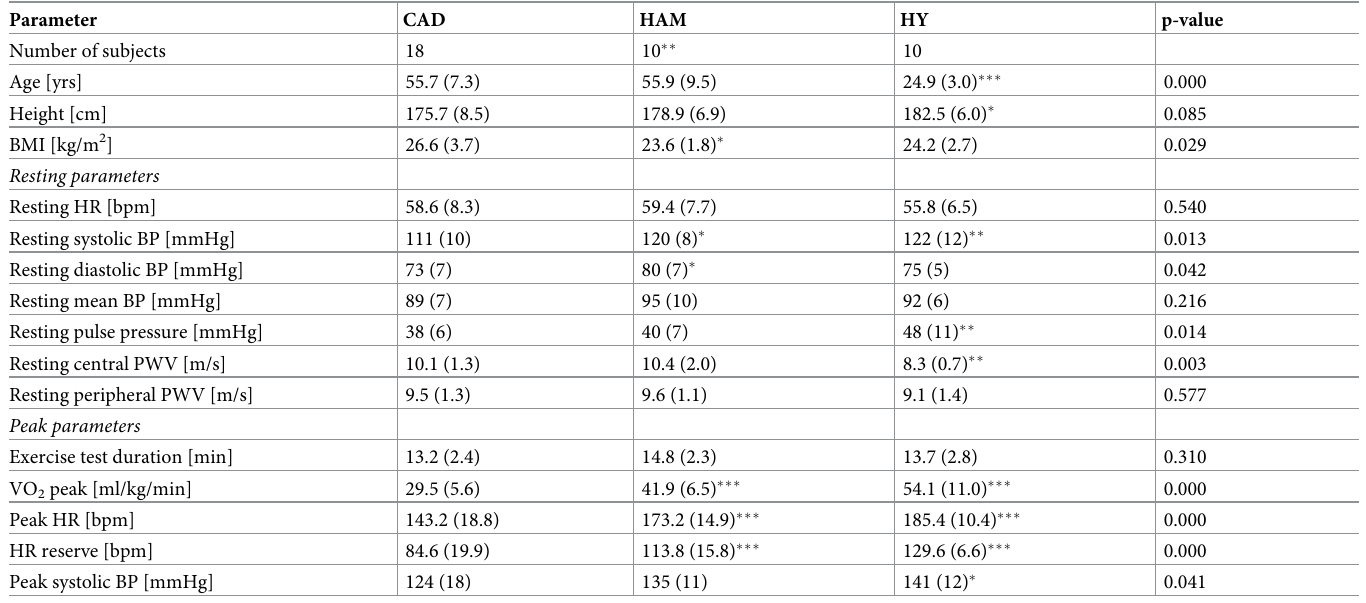
Table 1. Comparison of baseline characteristics of the three groups.